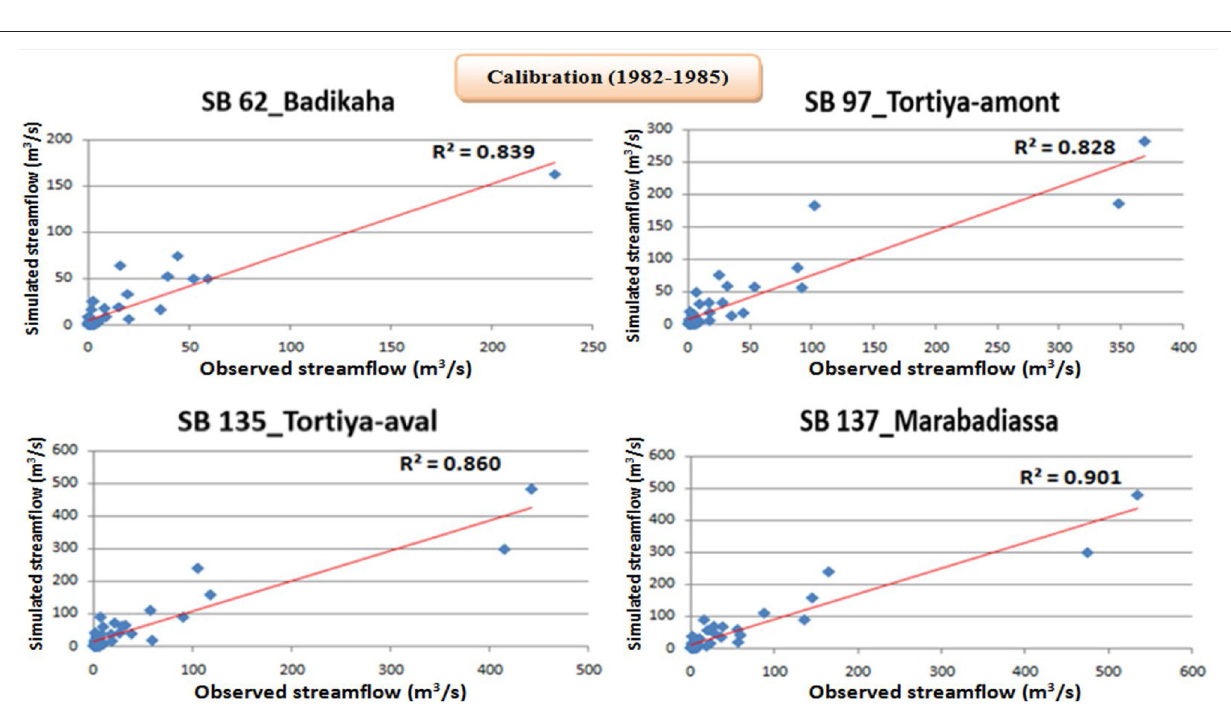
in GIS software (the order of the streamflow network, average stream slope, difference in level or water head, and protected areas such as national parks and reserves) ( Figure 11